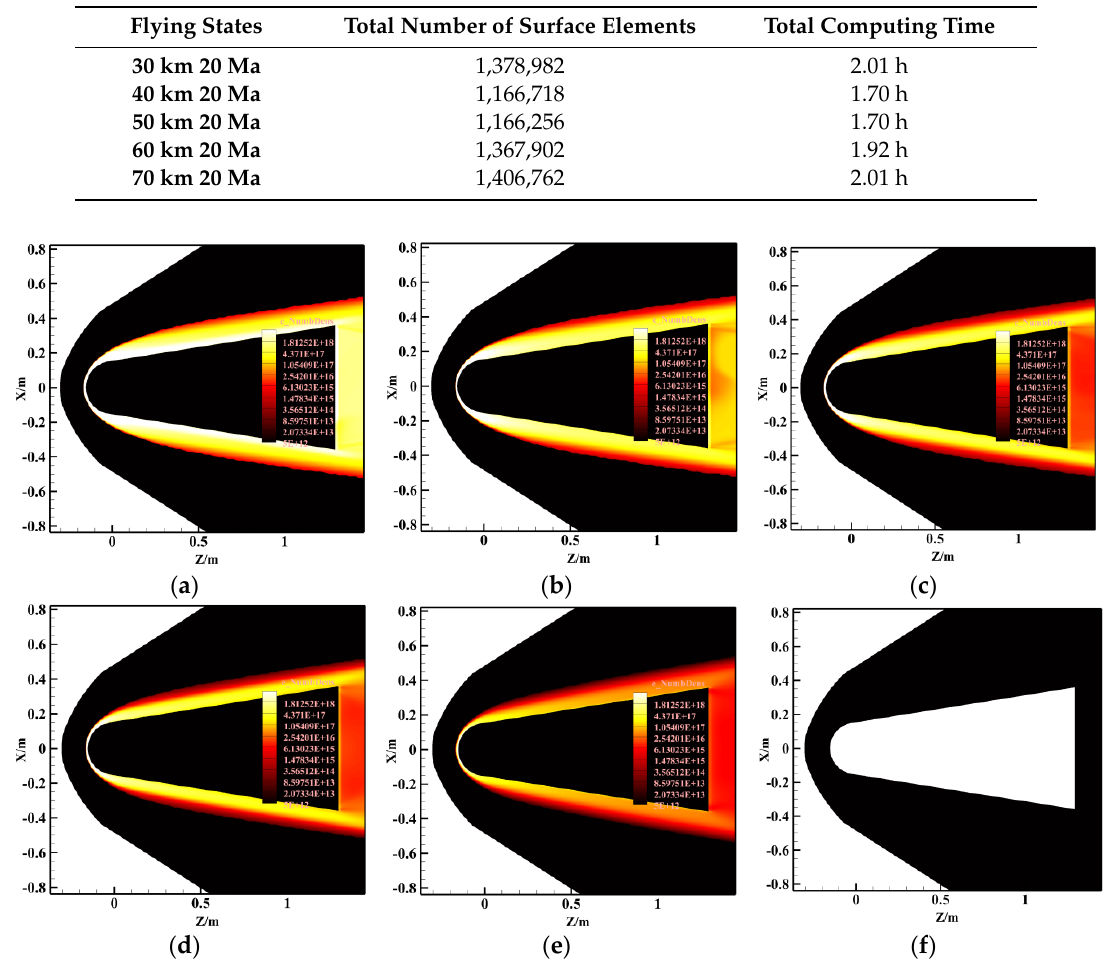
Figure 3. Electron density distribution field of the plasma sheath at: ( a ) 30 km, 20 Ma; ( b ) 40 km, 20 Ma; ( c ) 50 km, 20 Ma; ( d ) 60 km, 20 Ma; ( e ) 70 km, 20 Ma; and ( f ) 0 km, 0 Ma.